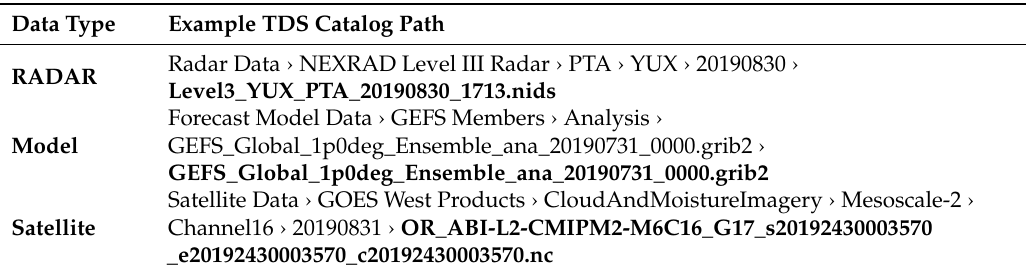
Table 2. Catalog paths of TDS datasets for three types of data. The catalog path hierarchy is marked in green. The dataset filename is marked in red.